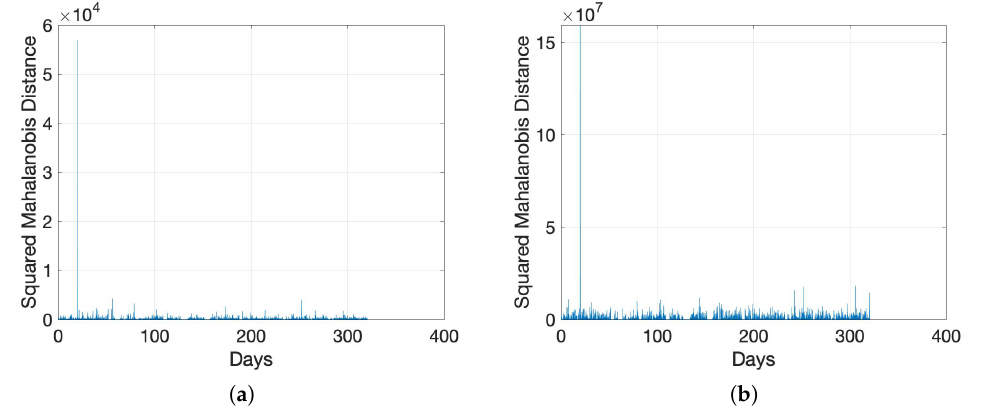
Figure 8. SMD for the in-field collected SNRs from the data set Exp MV . ( a ) Trained Using Exp MV2 ; ( b ) Trained Using Synthetic